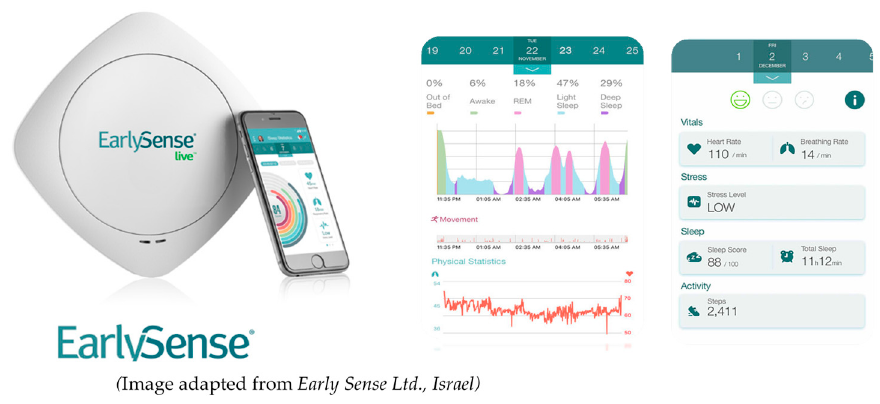
Figure 7. Early Sense for continuous real-time sleep tracking.